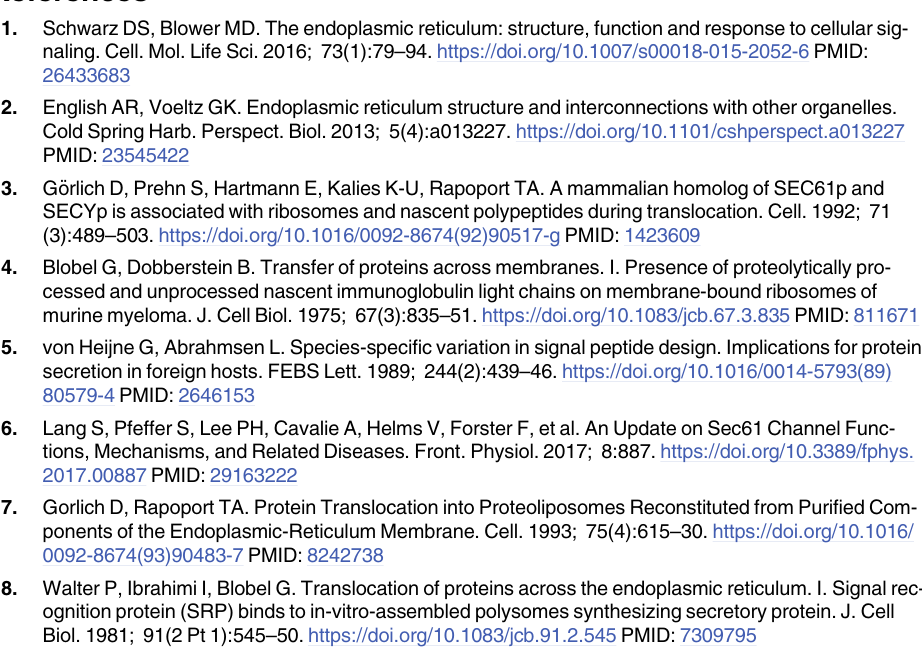
S4 Table. Antibodies used in this